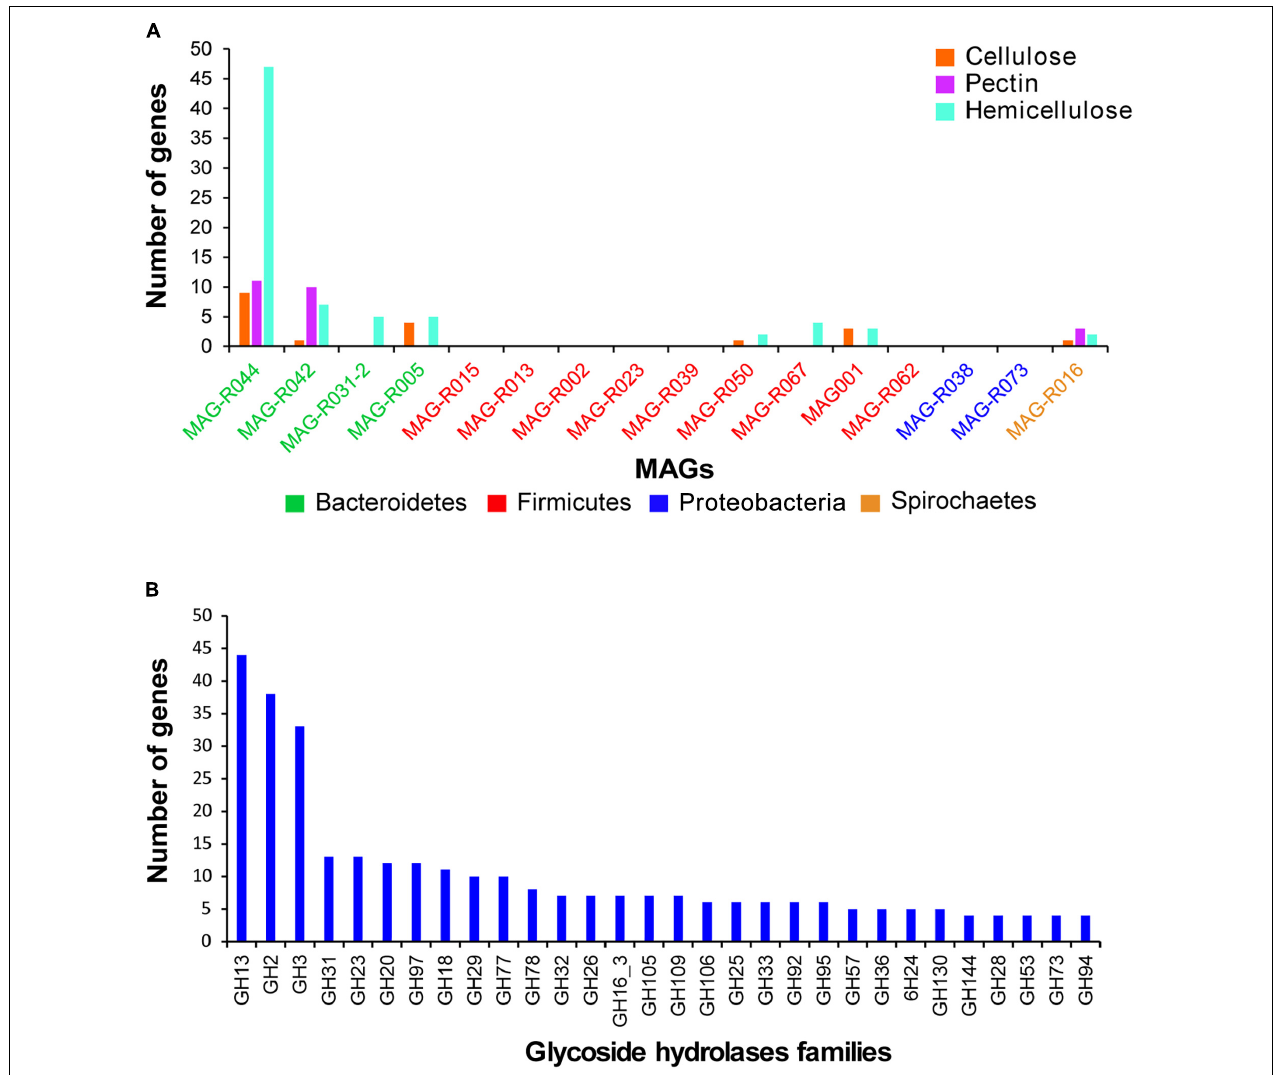
FIGURE 7 | Glycoside hydrolases found in the representative MAGs using dbCAN2 carbohydrate-active enzyme (CAZy) domain HMM database. (A) Gene counts per each MAG of enzymes degrading substrates such as cellulose, hemicellulose, and pectin, according to Seshadri et al. (2018). (B) Gene counts for other glycoside